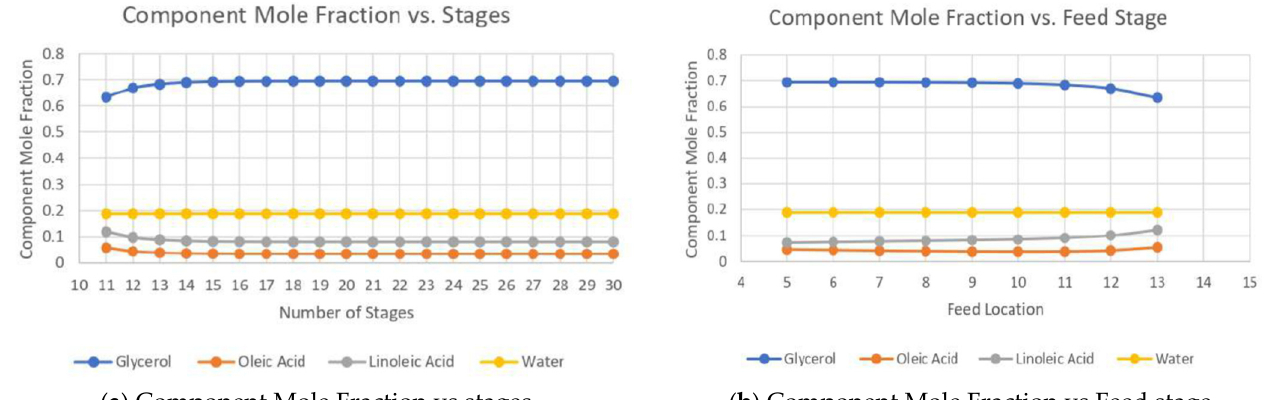
Figure 4. Sensitivity Analysis on distillation block B7.